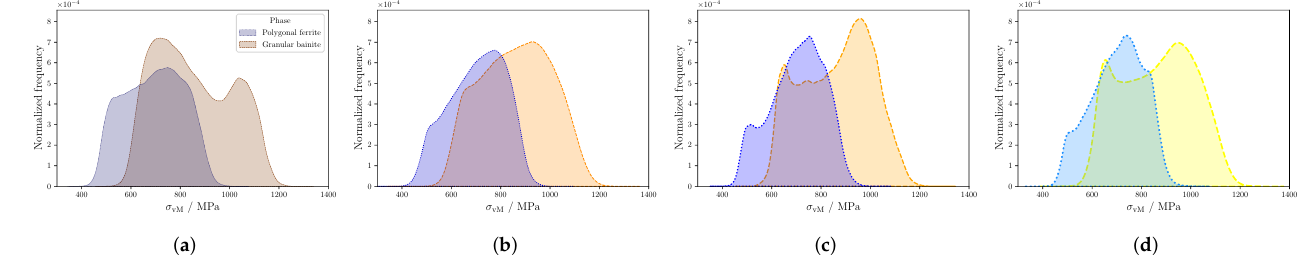
Figure 9. Stress distributions at the final applied strain for 2D-RVE measured ( a ), 3D-RVE ( b ), 3D-RVE no-substructure( c ), and 3D-RVE gb-substructure ( d ) RVEs. Polygonal ferrite is colored in blue tones and granular bainite in orange tones.